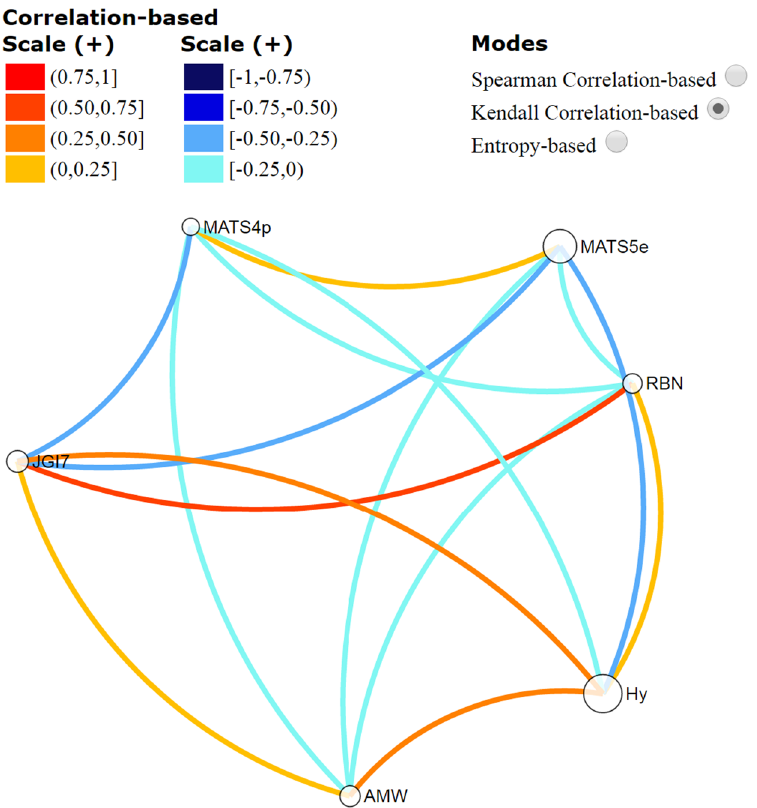
Figure 3. Redundancy analysis among the molecular descriptors that conforms the model M13 BBB